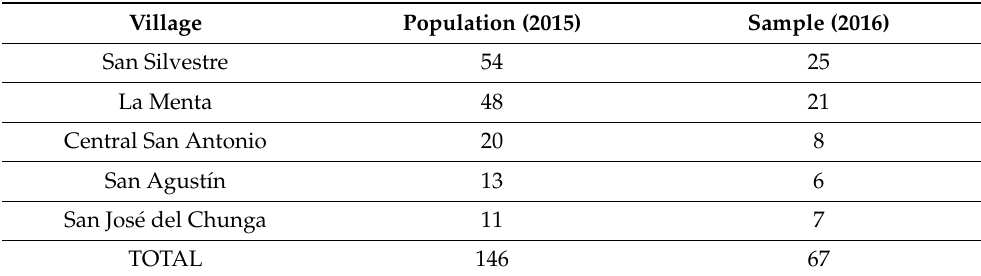
Table 1. Population and sample in the study area of the Sibundoy